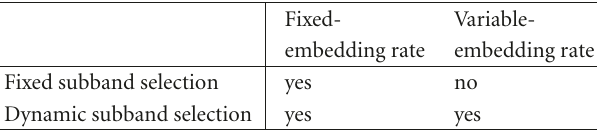
Table 1: Subband selection options.